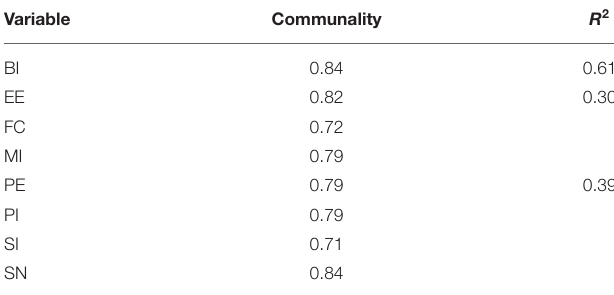
TABLE 7 | Communality and R 2 of the path model after adding mediation